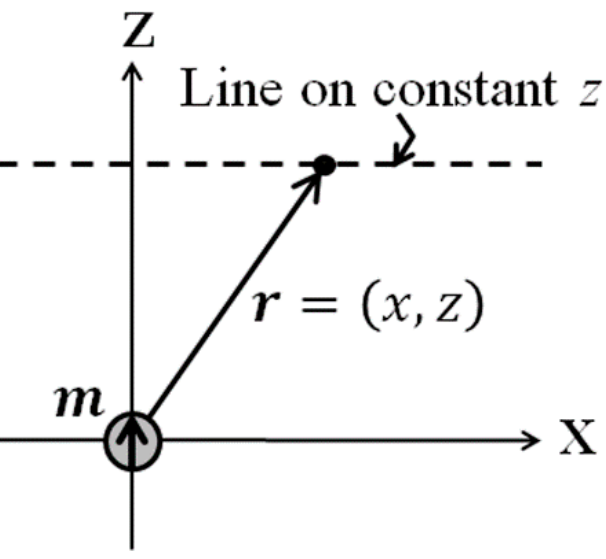
Figure 2. Schematic of the analysis coordinates [21].